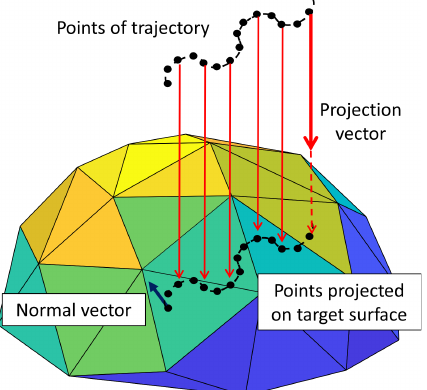
Figure 1. The concept of the algorithm is to project a set of ordered points of a trajectory at a given direction on a non-planar tessellated